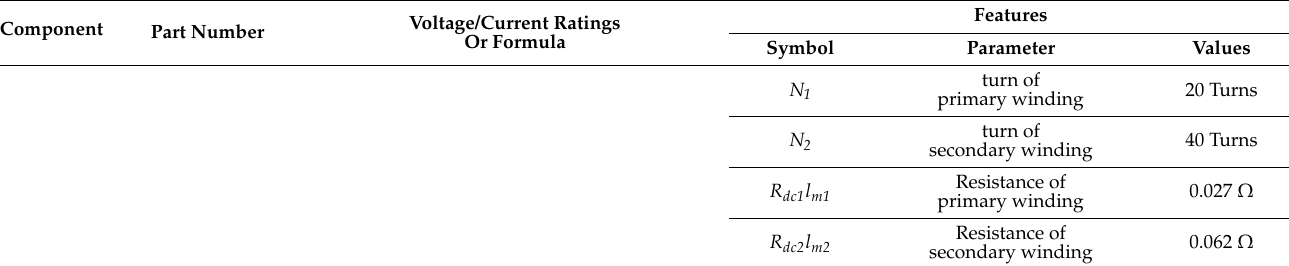
Table 8. Power loss analysis of the proposed hybrid converter under V B = 12 V and output maximum current I o ( max ) = 2 A. Component